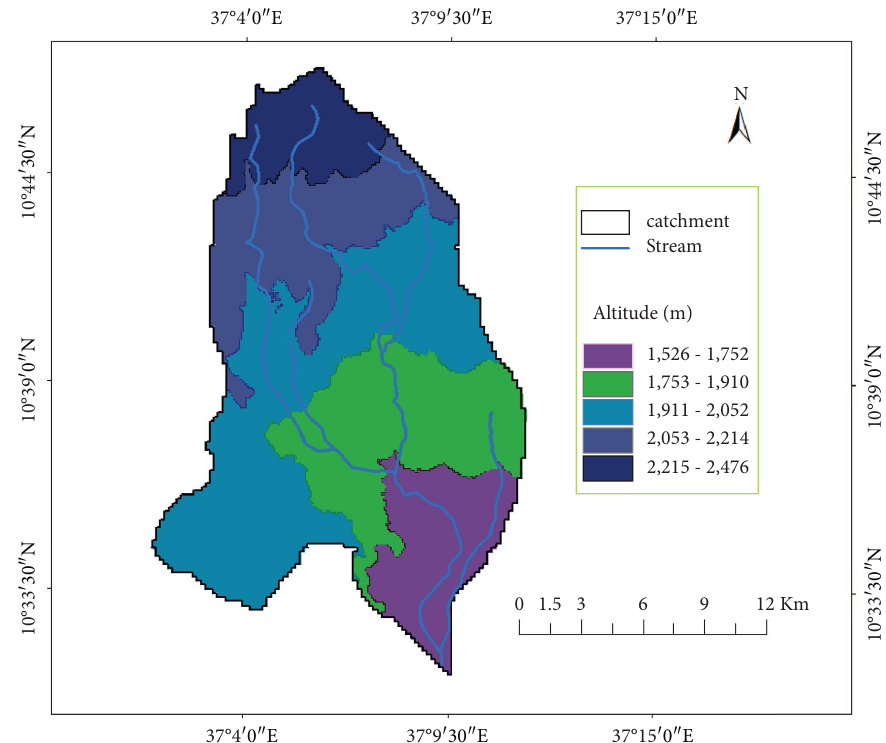
Figure 2: Drainage and elevation map of the